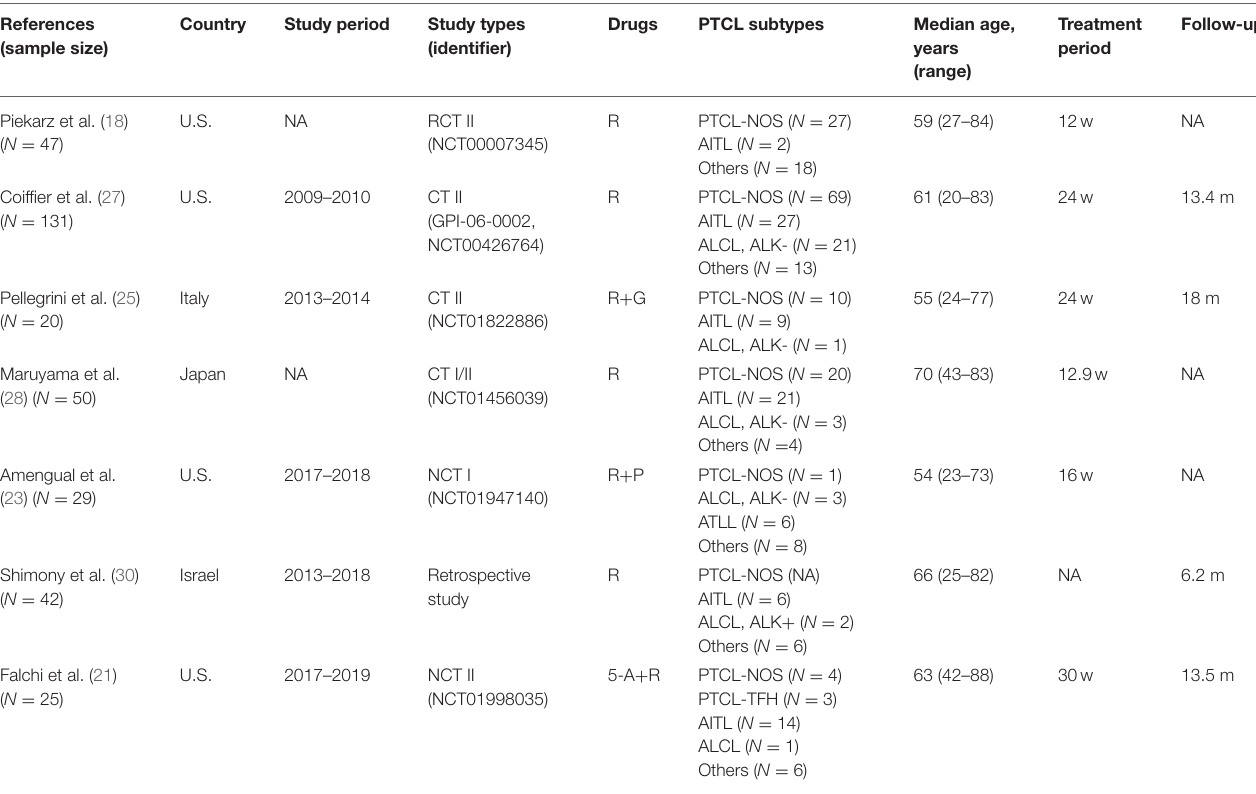
TABLE 2A | Characteristics of the included studies for treatment-related adverse